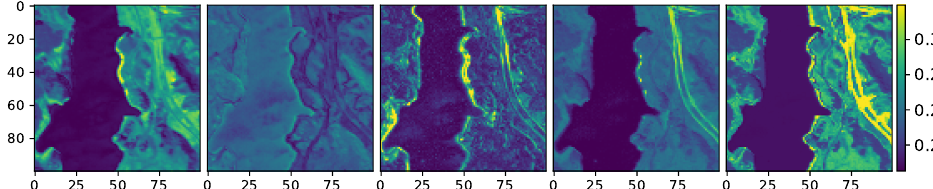
Figure 8. Energy of the nonlinear components of the Jasper Ridge data. From left to right: VCA-K- Hype, N-FINDR-NDU, rNMF, DAEN, and the proposed method,